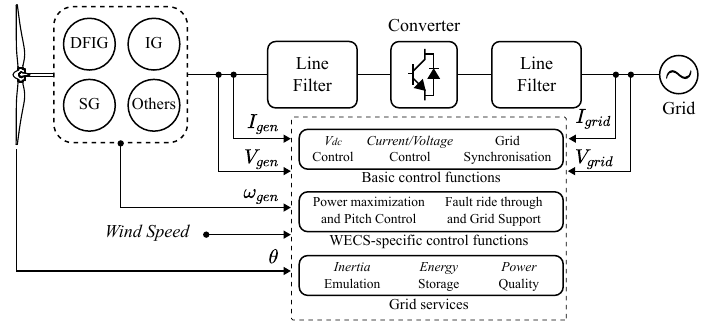
Figure 2. Overall control requirements for grid-connected